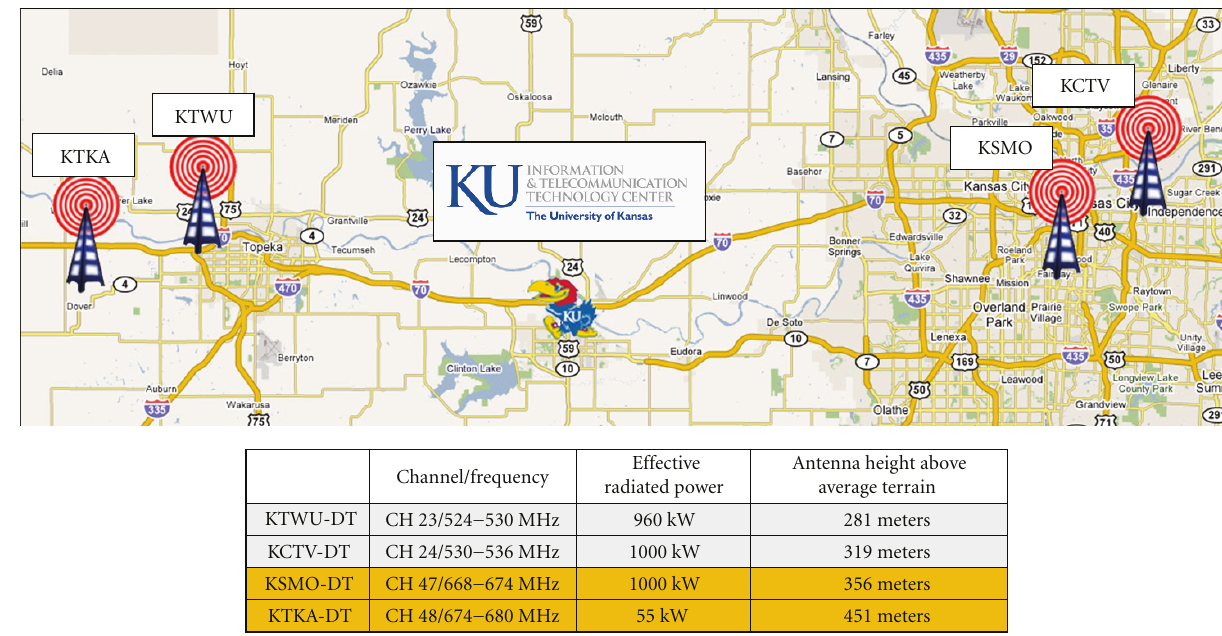
Figure 5: Adjacent channel DTV broadcast reception in Lawrence, KS.